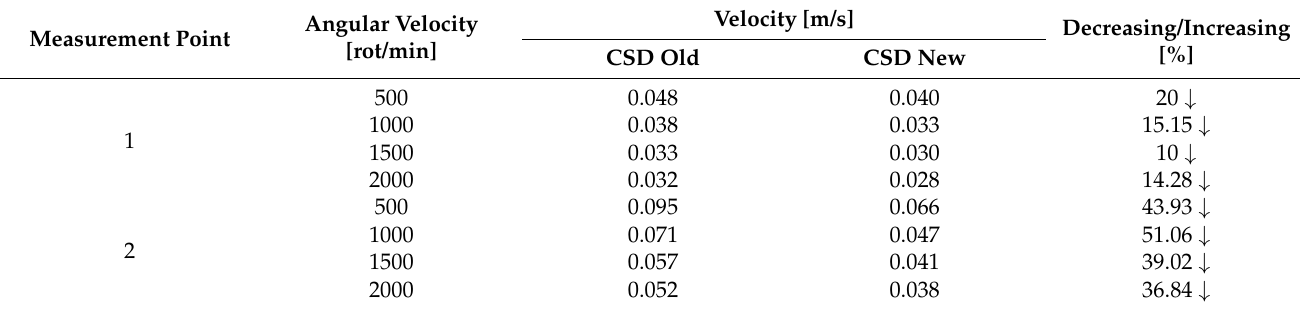
Table A2. The determined velocities accelerations on six points of the adder gearbox. Measurement